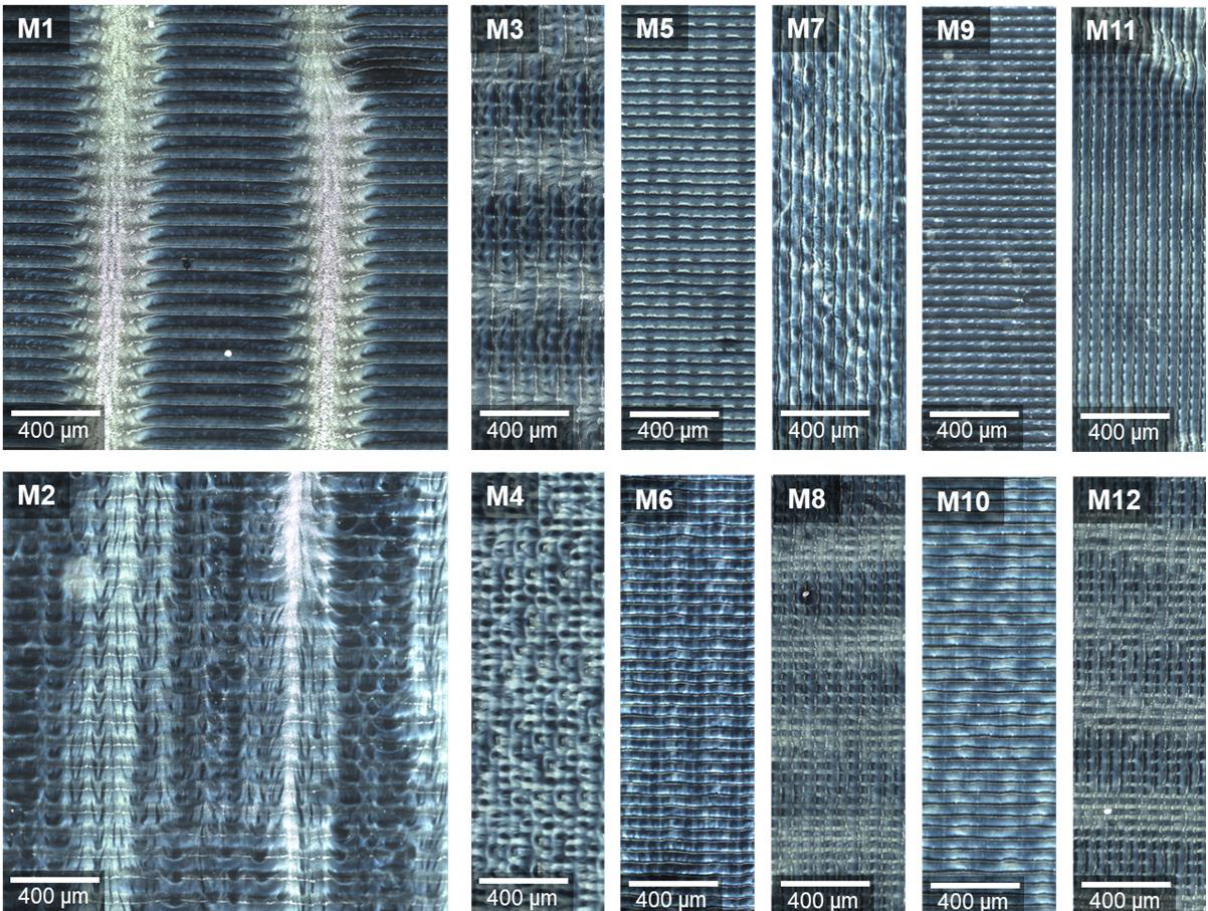
Figure 6. Dark field images of ODFs imprinted at varying print settings (defined in Table 2), stitching images of an area 2000 × 2000 µm (M1–M2, M3 cut) and 2000 × 600 µm (M4–M12), rotated by 90° for observation under the microscope.